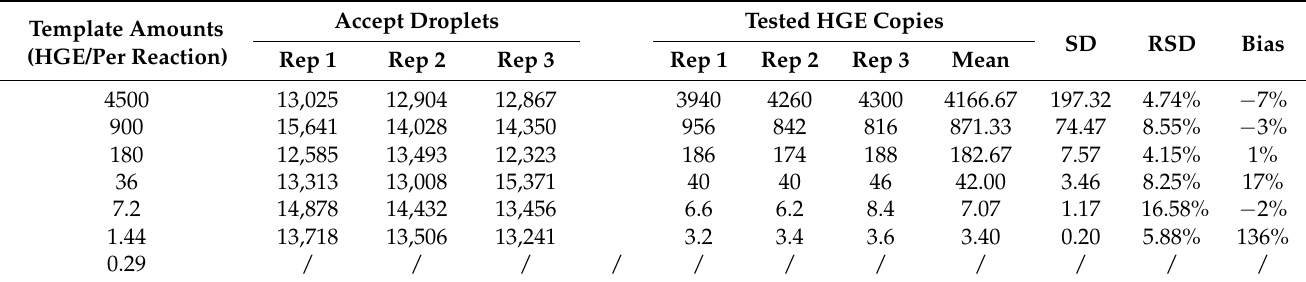
Table 2. LOD and LOQ of the KoP1 event-specific ddPCR